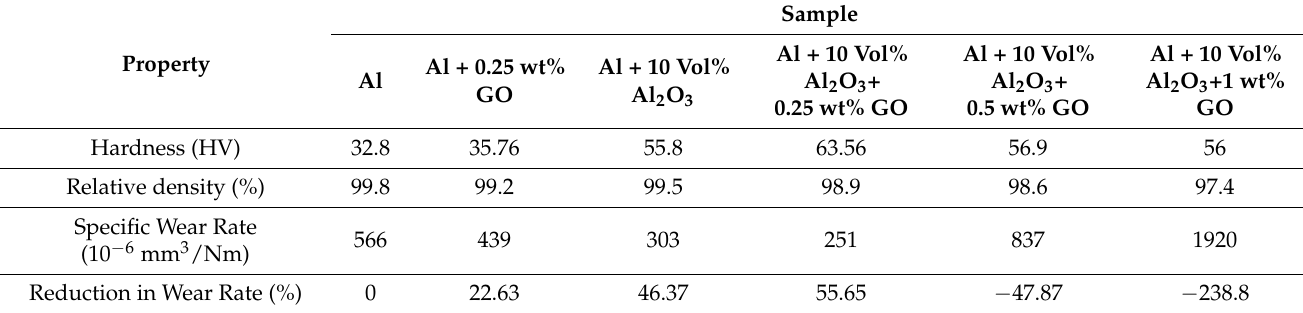
Table 3. Summary of the results obtained in the current